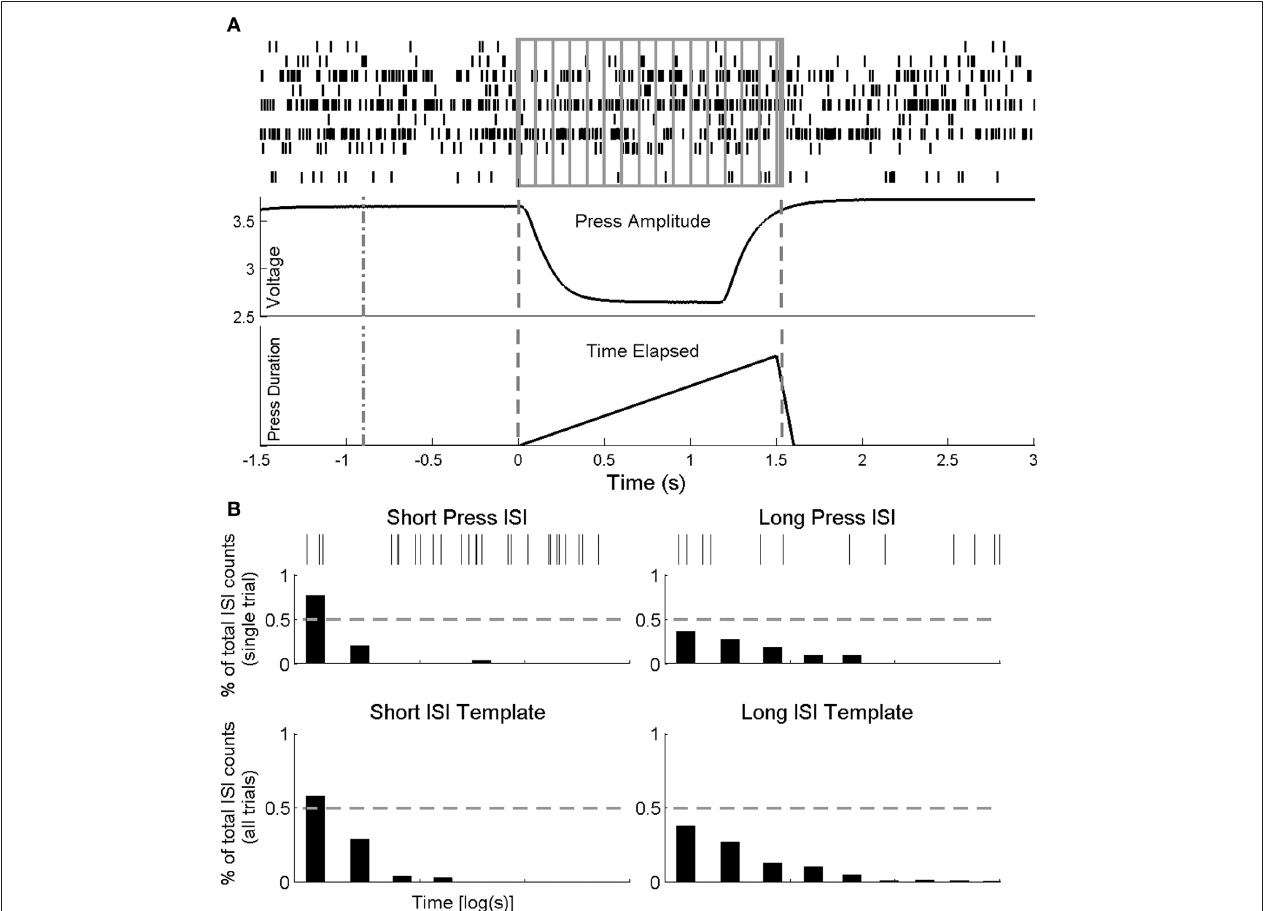
FIGURE 2 | Single-trial decoding methods. (A) Weiner filter. Spike times (top panel) for recorded neurons (one row per neuron) during a single pedal press (middle trace—amplitude of press; bottom trace—duration of press) are binned at 100ms and provide inputs into a linear model to predict press duration (see details of the Weiner filter in Methods). (B) Interspike interval classifier. Interspike timing during the first 1000ms from start of press is used to classify press duration. Spike times (top panel) for a single cell during